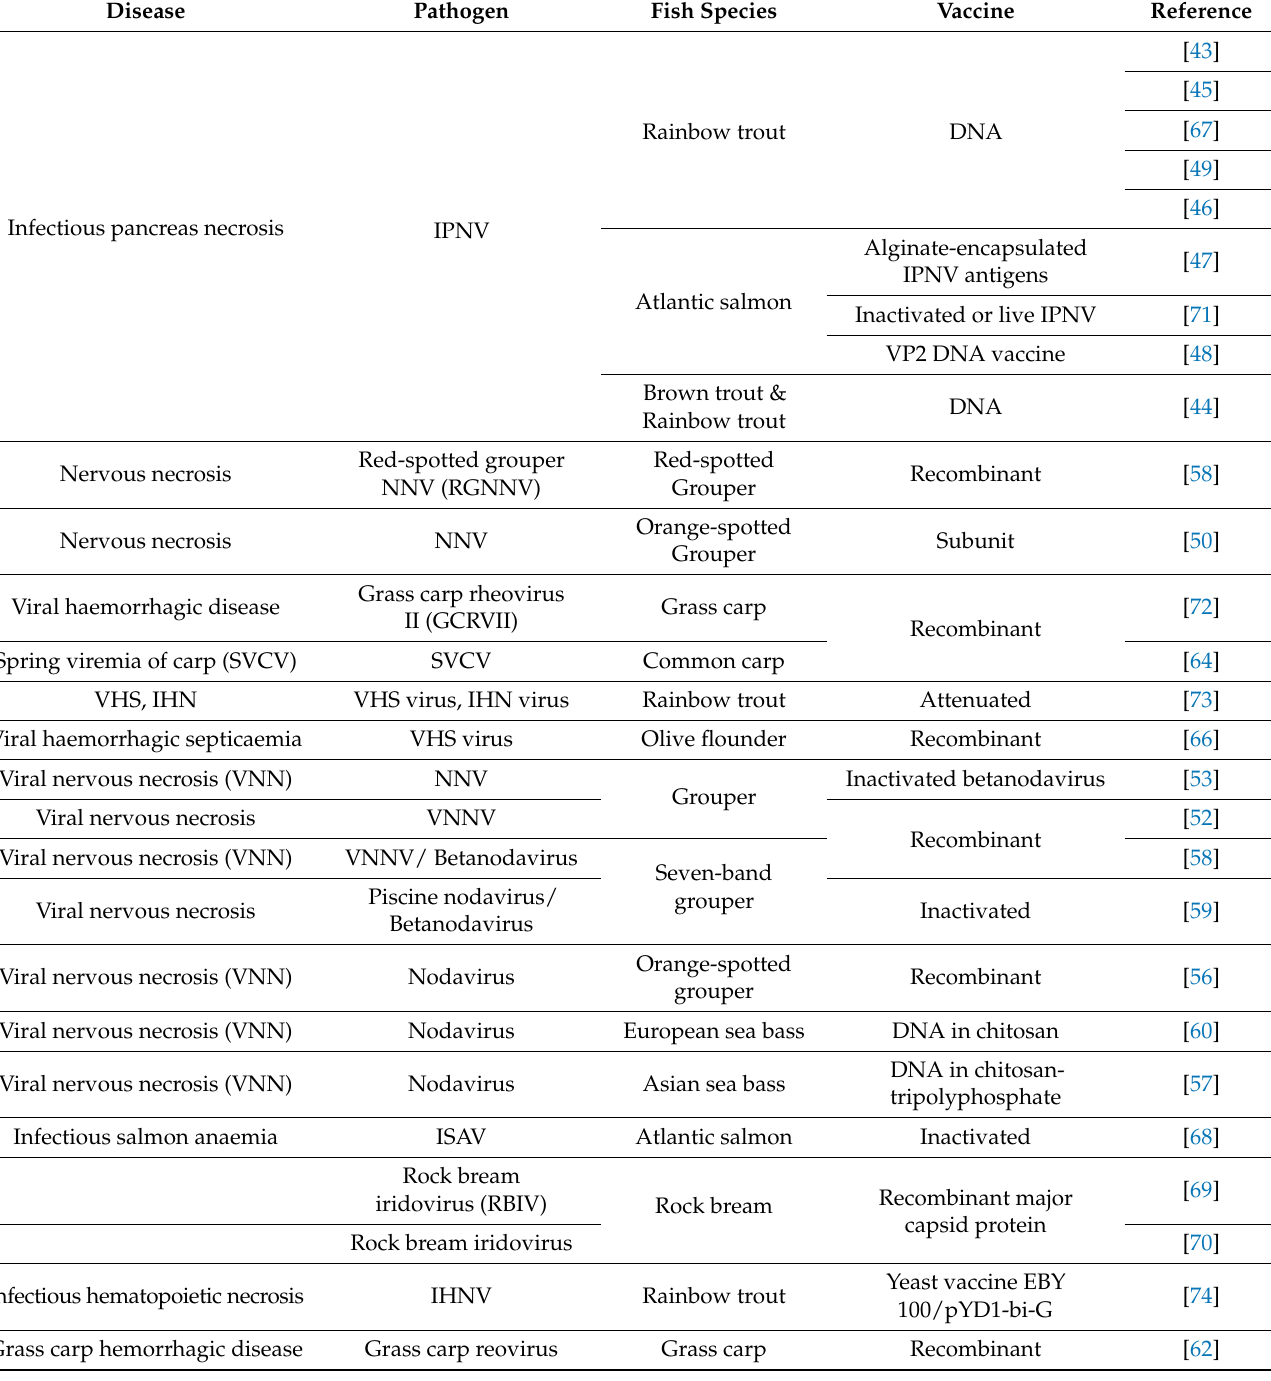
Table 2. Overview of recent oral vaccination trials against viral